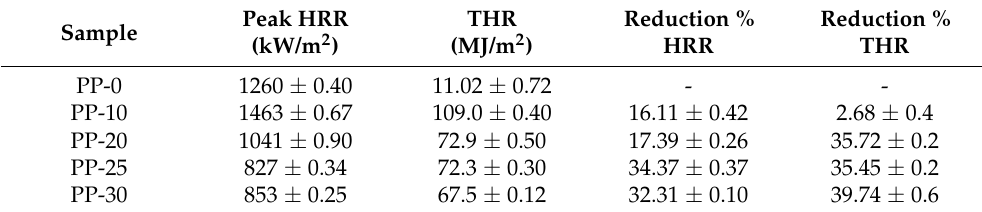
Table 3. Data of the cone calorimetry test of the samples